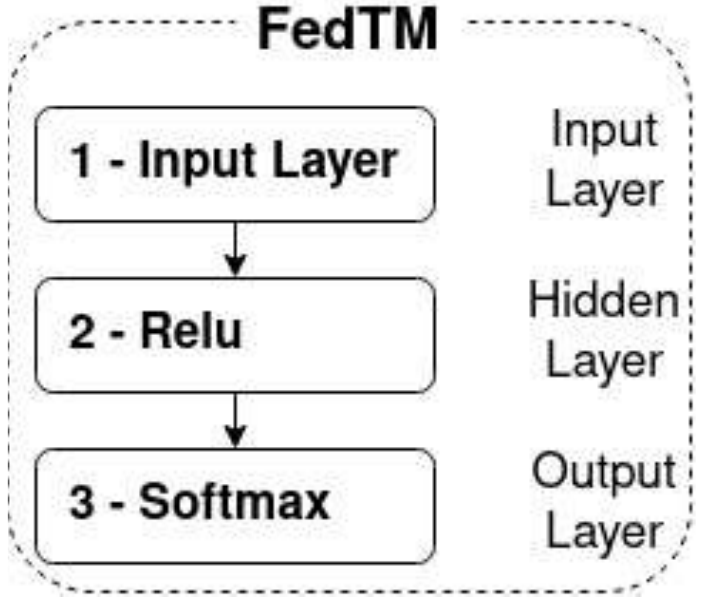
Figure 3. FedTM’s Neural Network